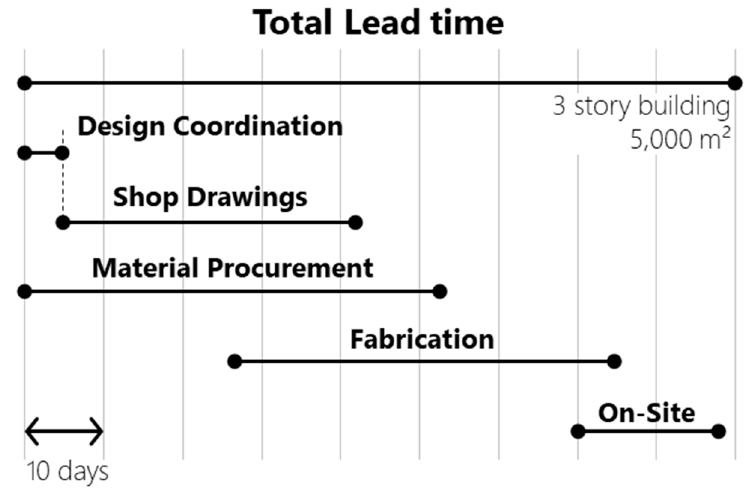
Figure 7. Typical project schedule of a ConXtech project (Source: authors).